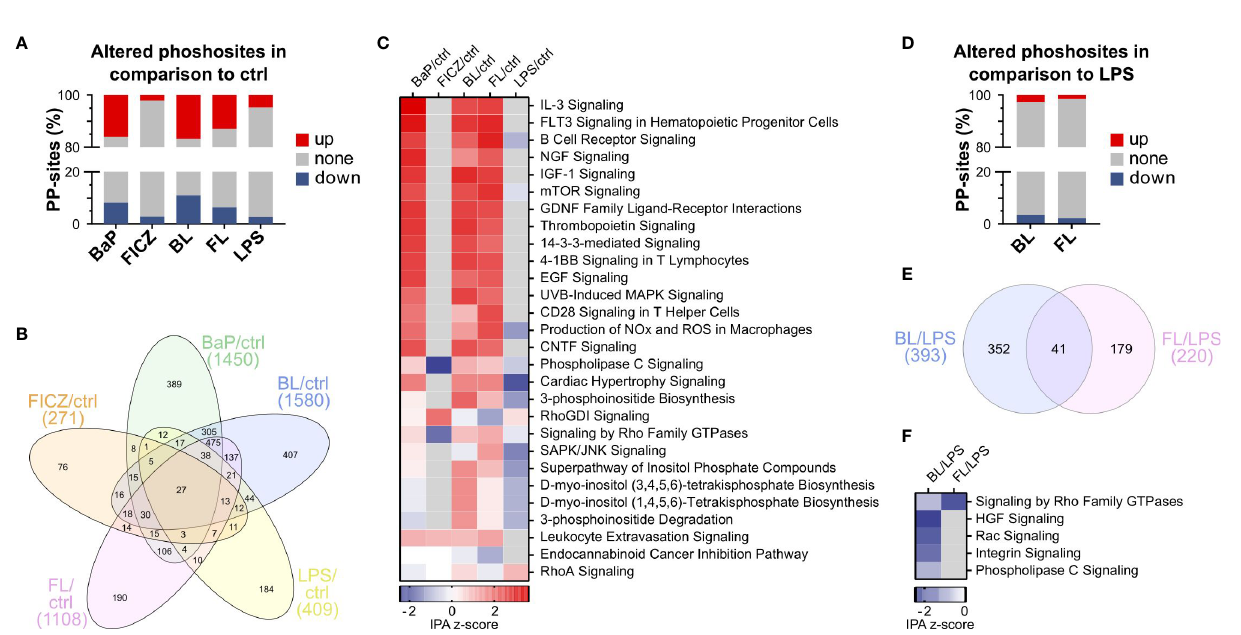
FIGURE 4 | Effect of AhR-activation on protein phosphorylation. (A) Percentage of signi fi cantly altered PP-sites compared to DMSO (ctrl) after 2h stimulation. PP- sites were considered as signi fi cantly altered compared to the control with a p-value ≤ 0.01, as determined by Student ’ s t-test (n = 4). (B) Overlap of altered PP-sites between different treatments. (C) Pathways enriched among regulated PP-sites compared to the unstimulated control. Pathway enrichment analysis was conducted using the phosphorylation-dependent pathway analysis functionality of Ingenuity pathway analysis (IPA). Only pathways with an enrichment p-value ≤ 0.01 were considered enriched. Shown are the top 10 pathways enriched for each treatment. (D) Percentage of signi fi cantly altered PP-sites in BL- and FL-treated cells compared to LPS alone (p ≤ 0.01, n=4). (E) Overlap of altered PP-sites in BL and FL-treated macrophages. (F) Pathways enriched among PP-sites regulated after BL- or FL-treatment compared to LPS (p ≤